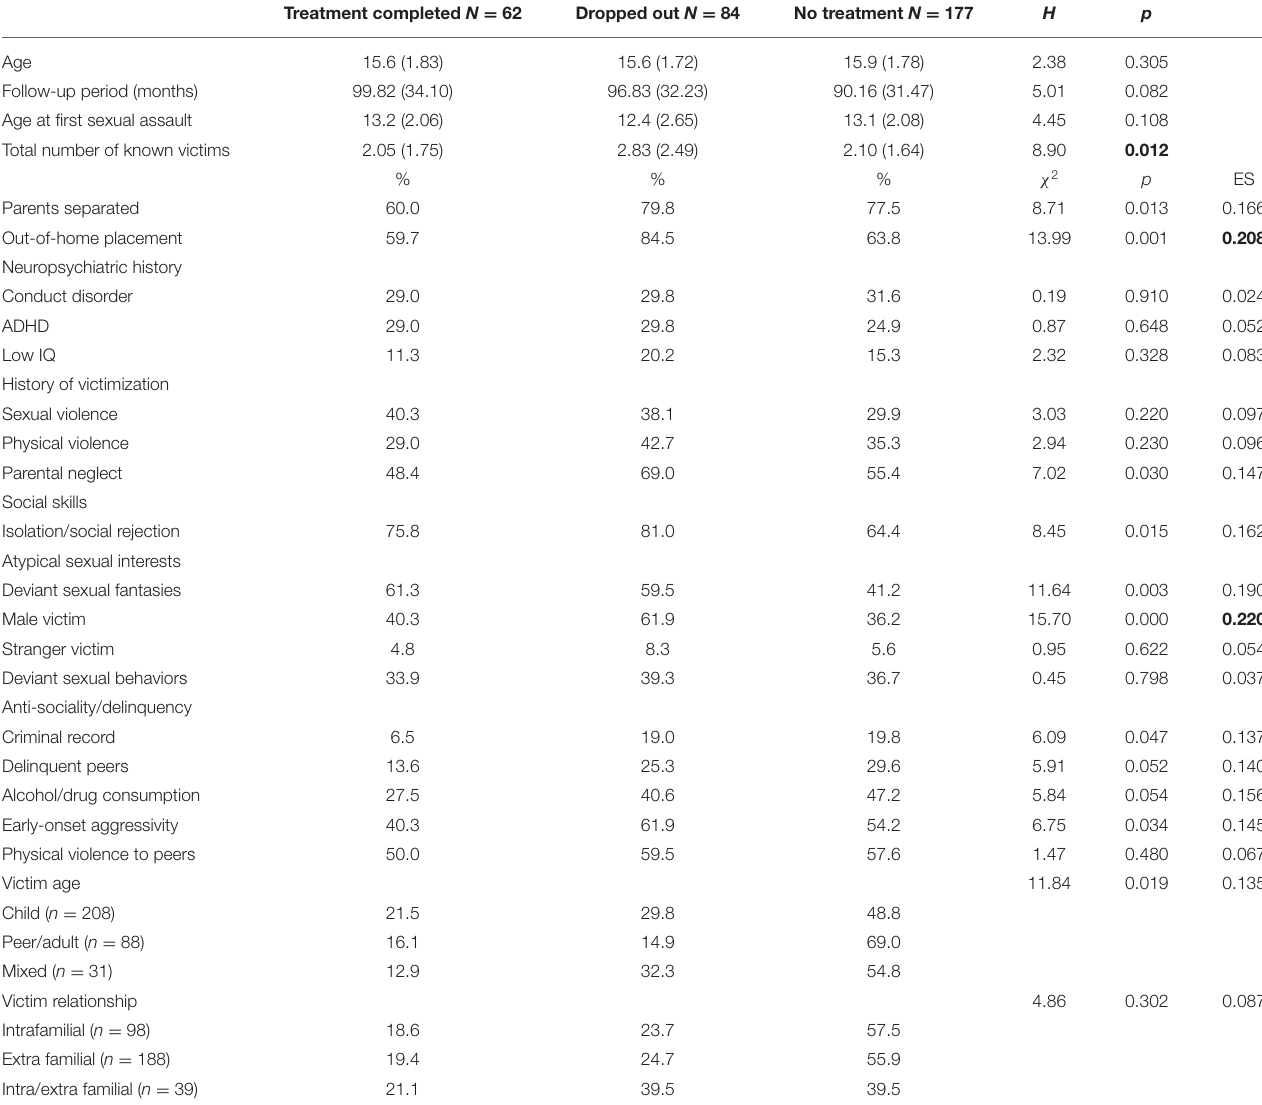
TABLE 1 | Mean (SD) and distribution of variables in the three groups (treatment completed, dropped out, no treatment). Treatment completed N = 62 Dropped out N = 84 No treatment N = 177